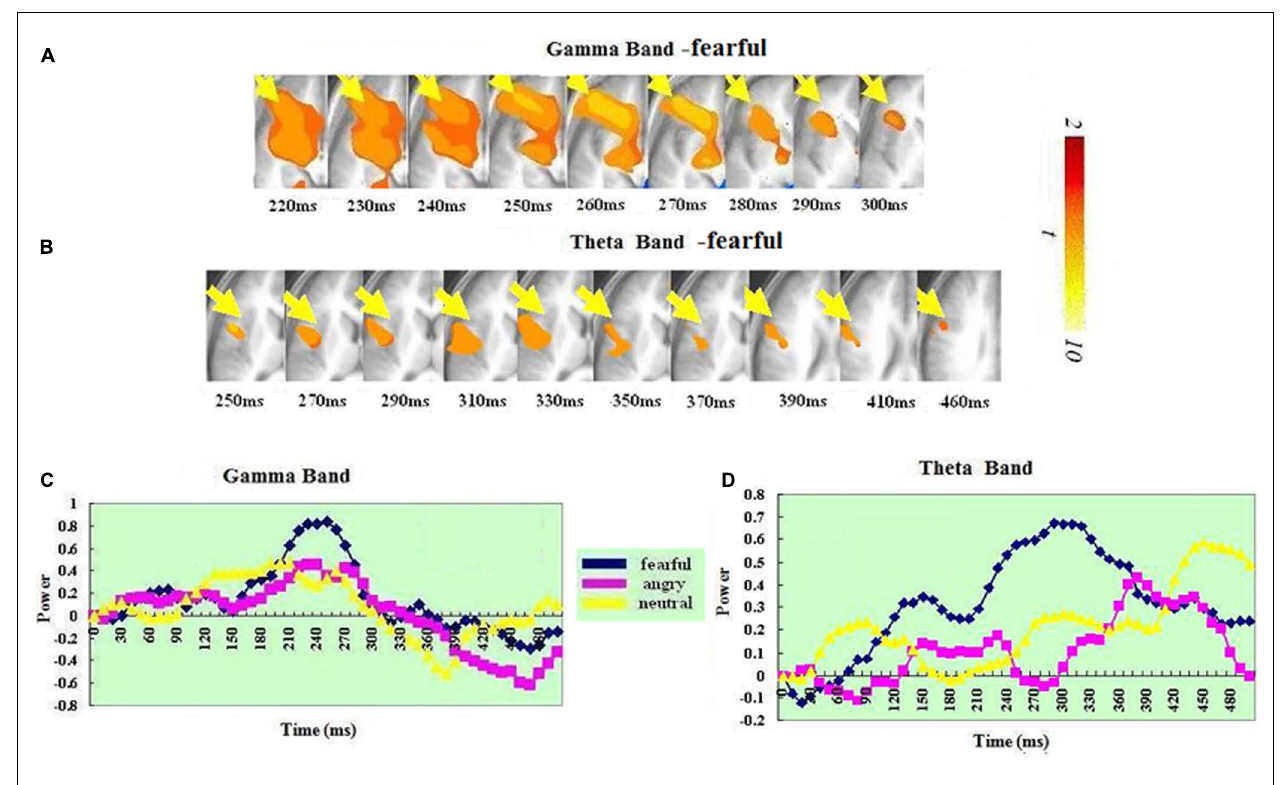
FIGURE 3 | Spatiotemporal profiles for IFG-insula in the in the gamma and theta bands. The brain map series (A,B) indicate the ERS development in specific brain areas with the left hemisphere is on the right and the right hemisphere is on the left.The curves (C,D) represent temporal profiles obtained from a peak voxel in a specified area in the three conditions respectively.The time courses are obtained from the normalized power value